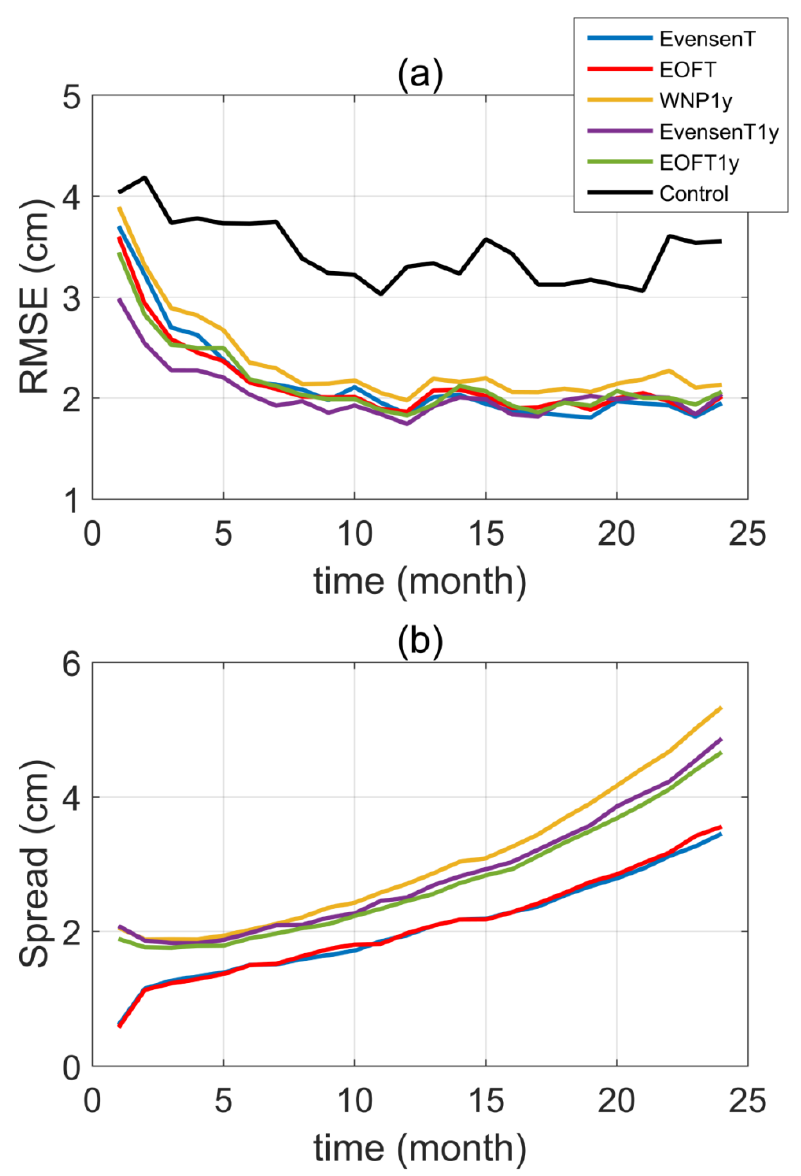
Figure 9. Time series of RMSE ( a ) and spread ( b ) of the SSH compared with the true data for the six Figure 9 . Time series of RMSE (a) and spread (b) of the SSH compared with the true data for the six experiments in region (70 ◦ S~70 ◦ N, 180 ◦ E~180 ◦ W) for a two-year period. experiments in region (70° S ~ 70° N, 180° E ~ 180° W) for a two-year period. Table 3. p -Values obtained by ANOVA (the bold font represents the values greater than 0.05). SST SSS SSH p -Value 0.9748 0.0036